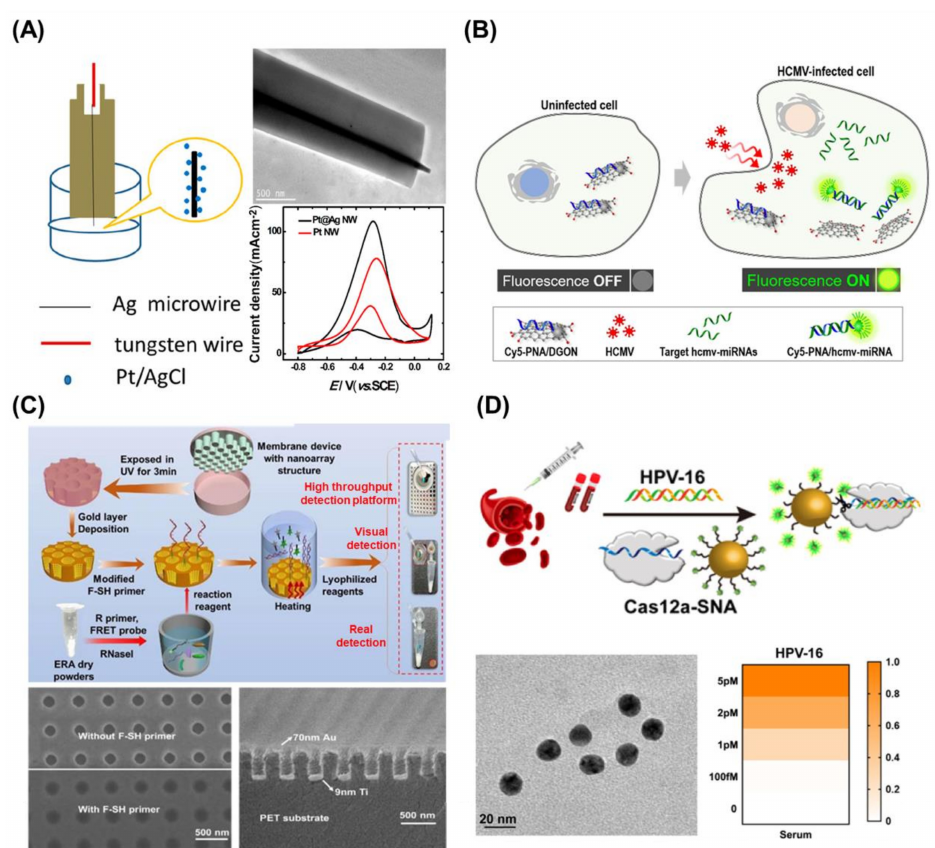
Figure 2. ( A ) Schematic diagram of a process for fabrication of single Pt@Ag nanowire, transmission electron microscope (TEM) image of fabricated Pt@Ag nanowire, and increase of current density of Pt nanowire after Ag modification. Reprinted with permission from ref. [35]. Copyright © 2019, American Chemical Society. ( B ) Schematic illustration of the HCMV diagnostic using dextran- coated GO nanocolloid (DGON) to detect the HCMV-encoded miRNA in the HCMV-infected living cell. Reprinted with permission from Ref. [48]. Copyright © 2021, American Chemical Society. ( C ) Schematic illustration of nanoplasmonic-enhanced isothermal amplification for